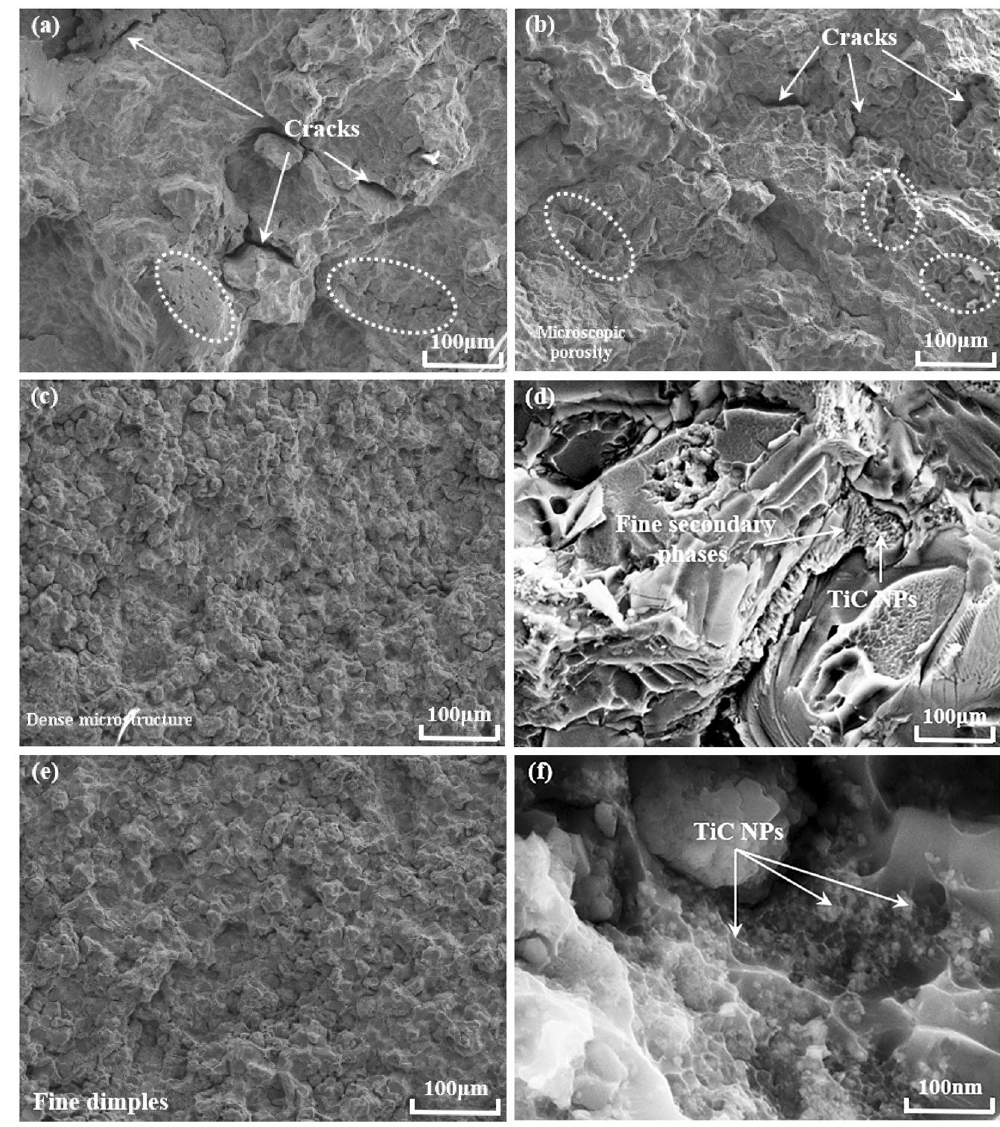
Figure 8. FESEM images of the fracture surfaces of AA7075 alloys with a cooling rate of 14.8 K/s. ( a , b ) AA7075 before and after heat treatment. Cracks and microscopic porosities were clearly observed and would lead to the failure of alloys; ( c , d ) nano-treated AA7075 (as-cast); ( e , f ) nano-treated AA7075 after heat treatment. With nanotreatment by TiC NPs, AA7075 alloys with dense microstructure were